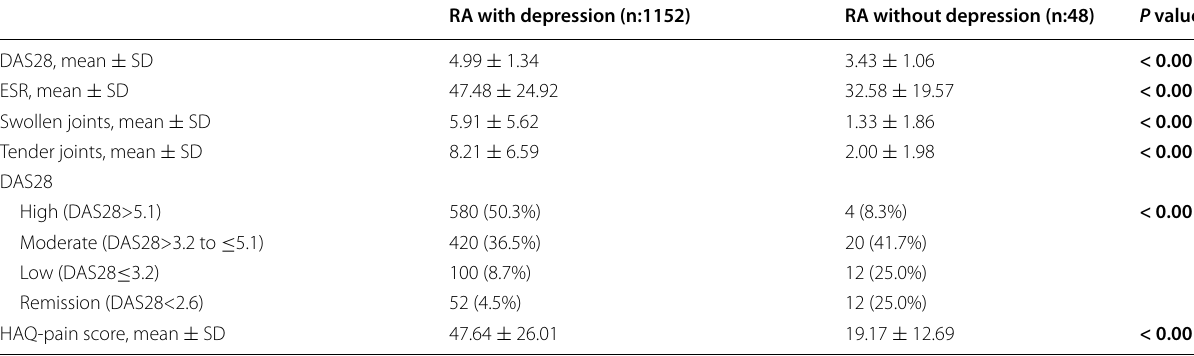
Table 2 The DAS28 (and related components) and HAQ in both RA groups RA with depression (n:1152)